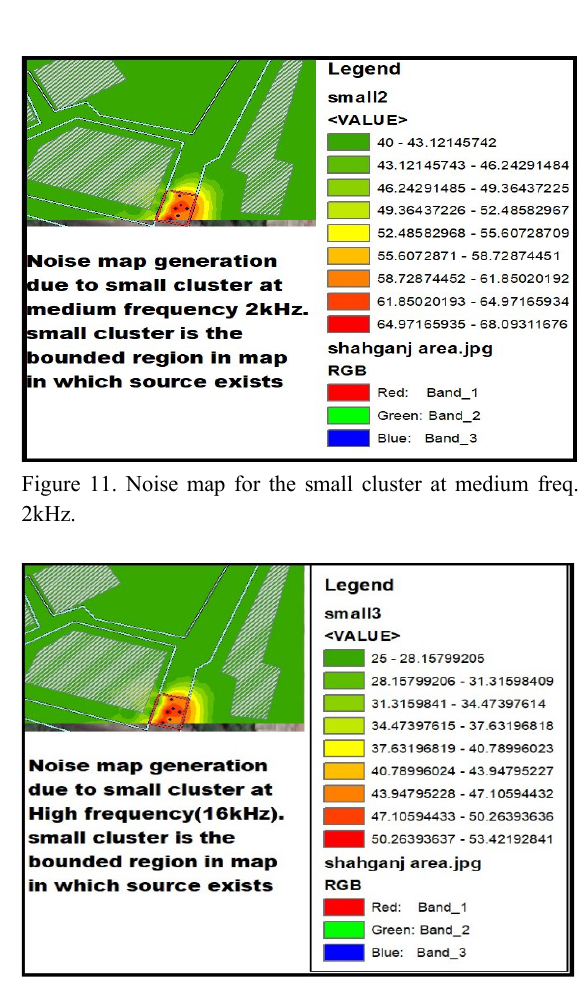
Figure 12. Noise map for the small cluster at large freq. 16 kHz. 3.5.2